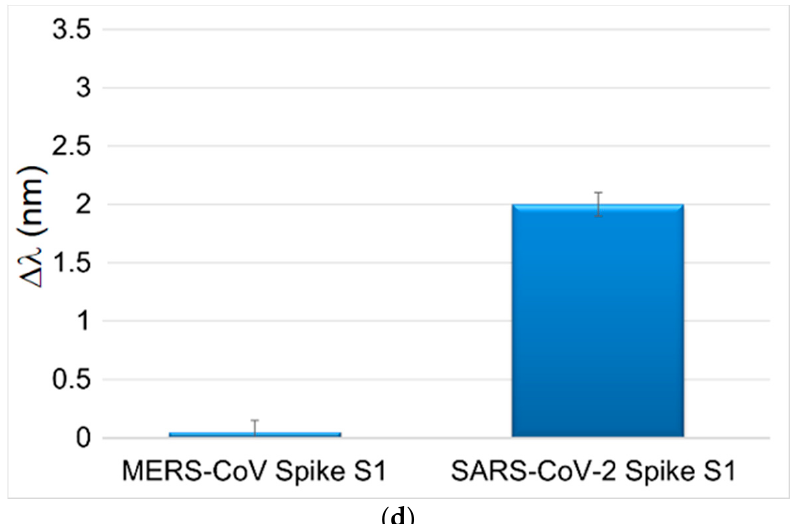
Figure 4. ( a ) Blue resonance peak: bare gold surface before the functionalization. Red resonance peak: red shifted resonance due to the MIP layer before template extraction with trypsin enzyme 4.2 × 10 − 8 M in buffer phosphate pH 7.4 and sodium dodecyl sulfate (SDS) 5%. Magenta resonance peak: Blue shift due to the freeing of sites from the template protein. ( b ) Response curves of Sars-Cov-2 Spike S1 subunit-MIP at different concentrations of protein. ( c ) SARS-CoV-2 Spike protein dose-response curve with the Hill fitting of the data. ( d ) Specificity test: sensor’s responses for MERS-CoV Spike protein and SARS-CoV-2 Spike protein, both with a concentration of 1 µM in UTM buffer. Table 3. Hill parameters of SARS-CoV-2 Spike protein detection.